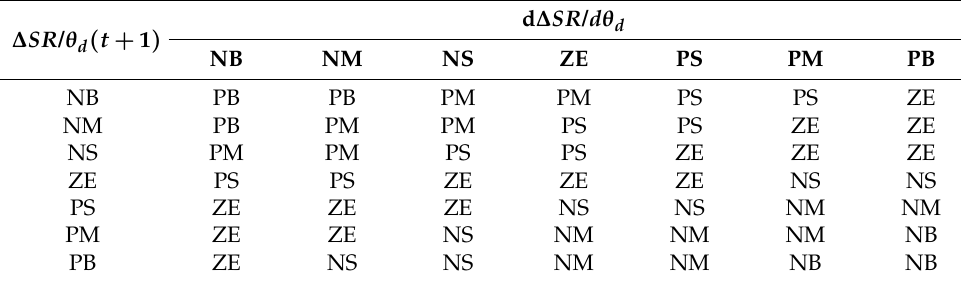
Table 2. Fuzzy rules for ∆ θ 1 and ∆ θ 2 .